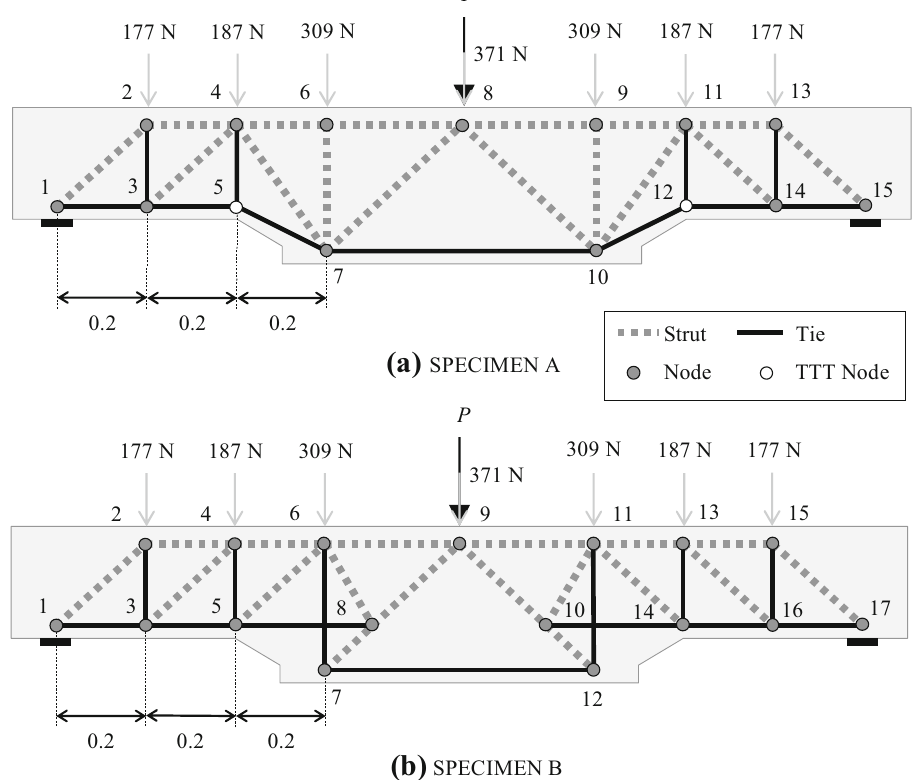
Fig. 3 Girder with geometrical discontinuity a solved considering TTT nodes, b solved not considering TTT nodes. The grey arrows correspond to the self-weight of the beam and load P corresponds to the applied load.